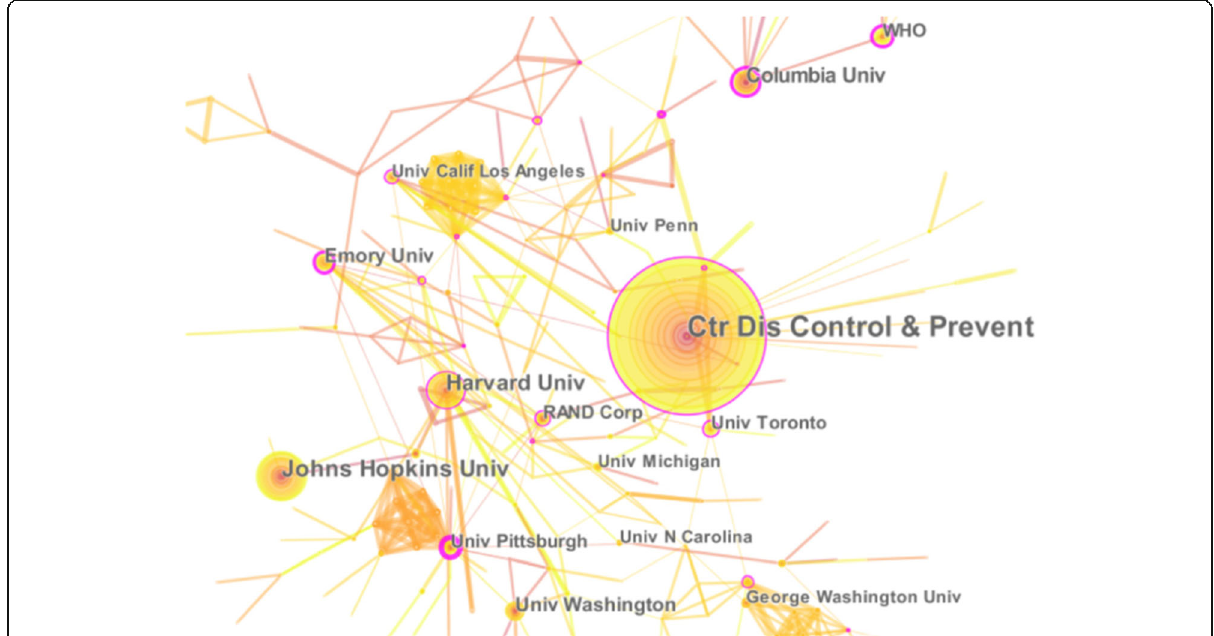
Fig. 5 Co-institution network of international database. Different colors represent different time slices. The colors of rings of a circle are corresponding to the year. The diameter of each circle represents the number of the institution ’ s articles. The link strength between two nodes means the intensity of institution cooperation. The purple circles represent the high betweenness centralities